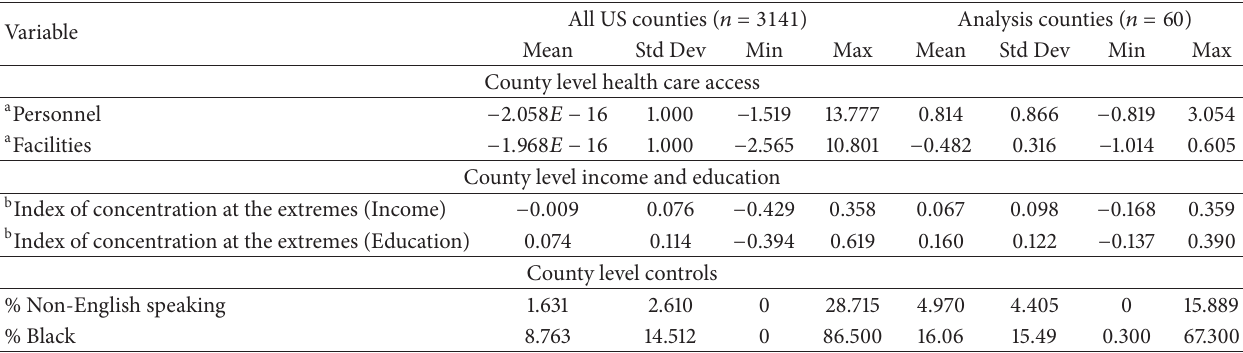
Table 1: Descriptive statistics of healthcare access and socio-economic characteristics of 3141 US counties in 2000-2001, Area Resource File